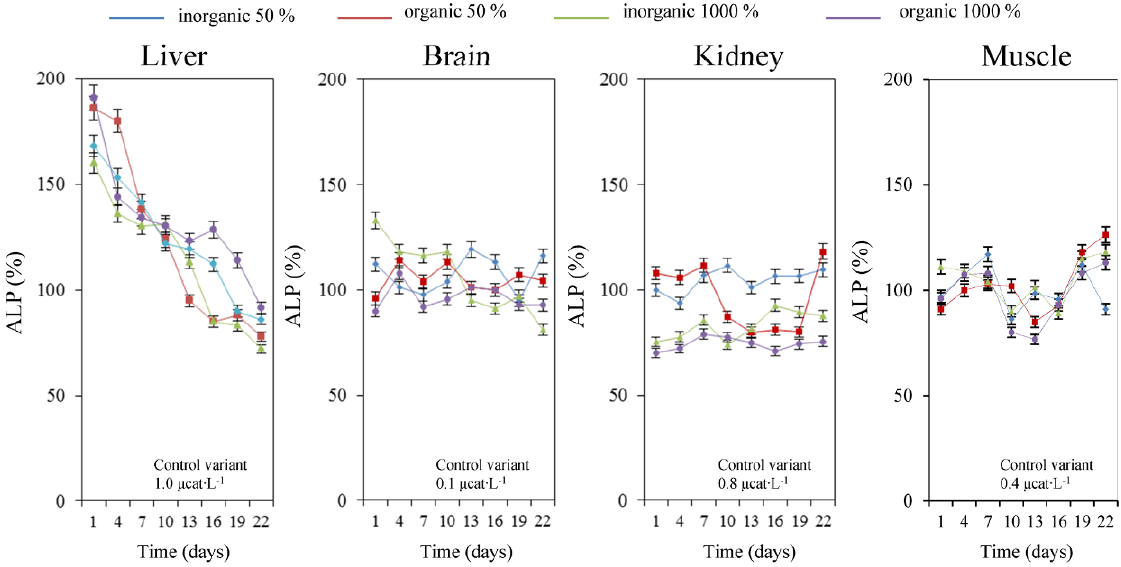
Figure 8. ALP activity in the examined organs. The level was related to the controls. Error bars indicate standard error of mean for three specimens. ALP was determined by spectrometric assay. The ALP activity results were related to a control group and recalculated as a percentage of control. Control group was determined as a one hundred percent from individual values as follows: liver 1.0 μcat L -1 , brain 0.1 μcat L -1 , kidney 0.8 μcat L -1 and muscle 0.4 μcat L -1